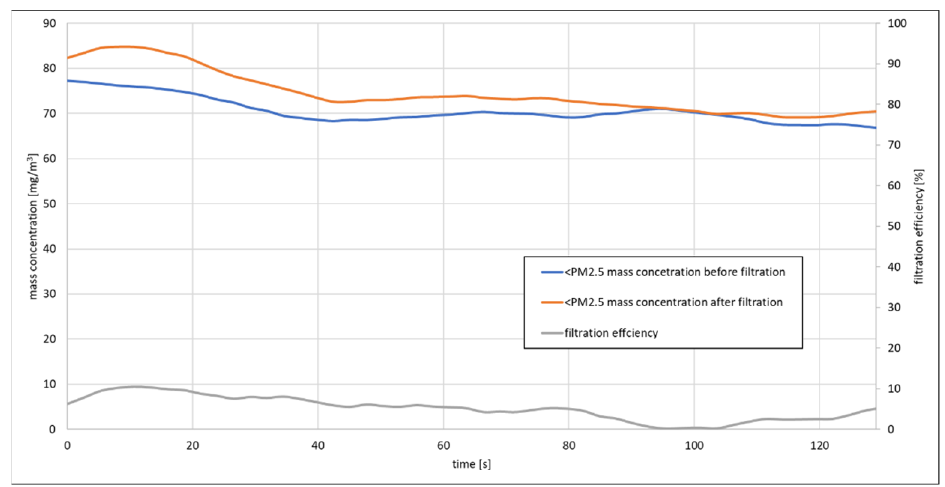
Figure 5. Mass concentrations of ≤ PM 2.5 size before and after filtration regarding filtration efficiency (temperature: 11 °C, relative humidity: 50%).